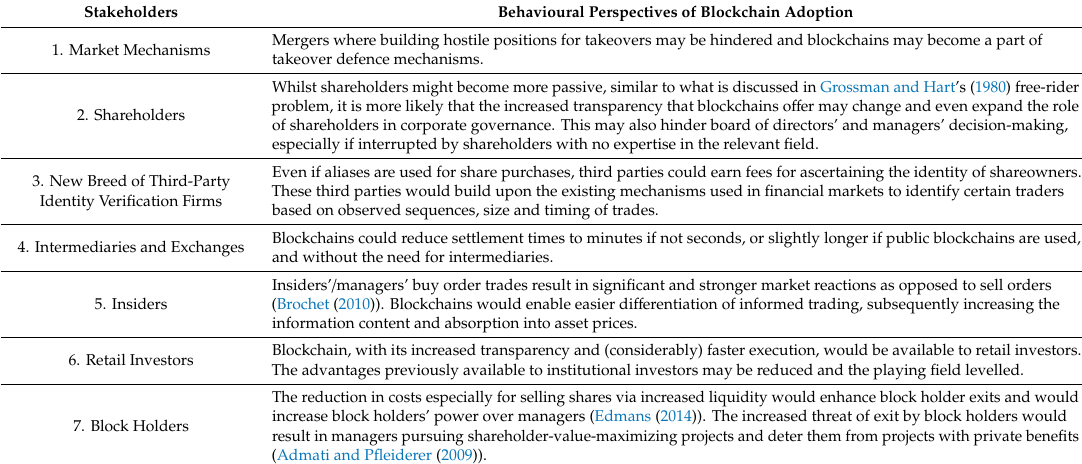
Table 7. Stakeholders and Blockchain Adoption Implications in Corporate